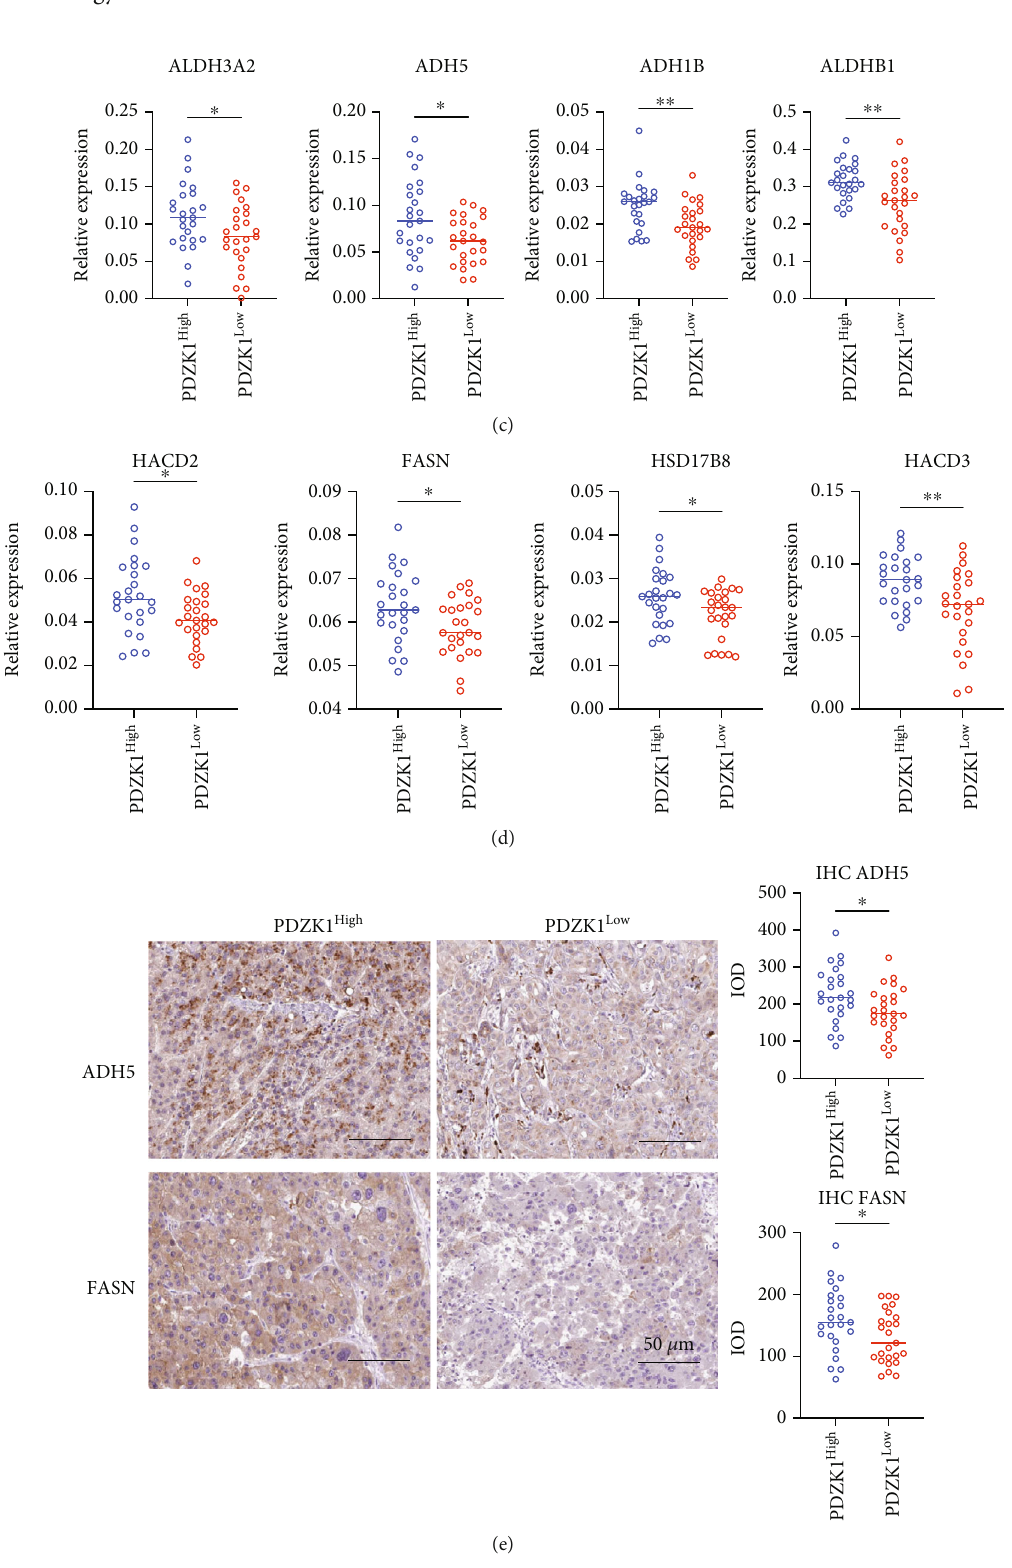
Figure 4: PDZK1 was correlated to increased PI3K/AKT and fatty acid metabolism. (a) Real-time PCR detection PI3K-AKT signaling- related genes indicated in the fi gure in PDZK1 high and low expression samples. (b) IHC staining of ITGA6, RAF1, and FGFR3 in PDZK1 high and low expression samples. (c, d) Real-time PCR detection fatty acid metabolism and degradation-related genes indicated in the fi gure in PDZK1 high and low expression samples. (e) IHC staining of ADH5 and FASN in PDZK1 high and low expression samples. Data are presented as mean ± SEM and were analyzed using Student ’ s t -test ( ∗ P < 0 : 05 , ∗∗ P < 0 : 01 ; ns: not signi fi cant, P > 0 : 05